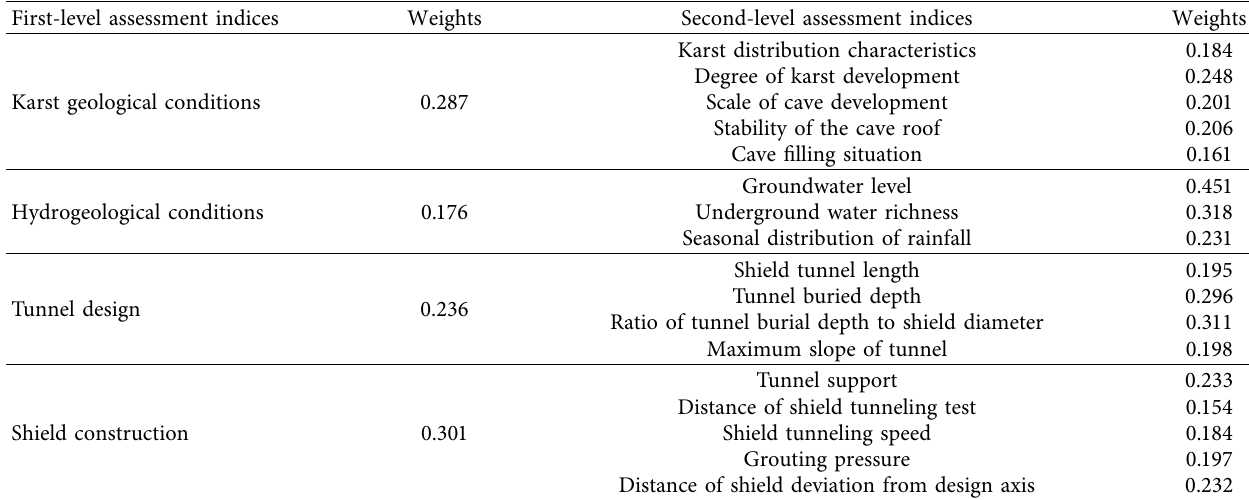
Table 5: Weights of risk assessment indices.